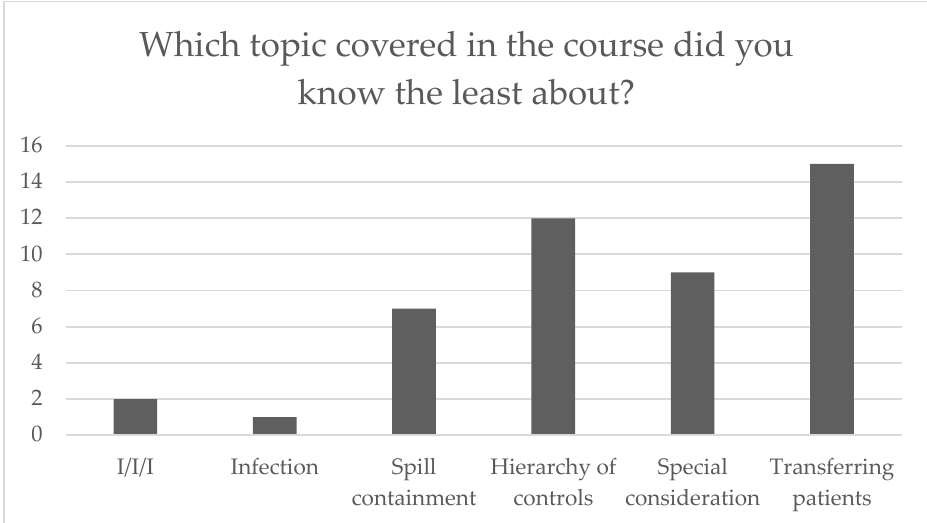
Figure 3. Of the 46 participants who answered this question, the topics most indicated as being new to participants were hierarchy of control (12), special consideration (9), and patient transfer (15). I/I/I represents the topic of “Identify, Isolate, Inform”.